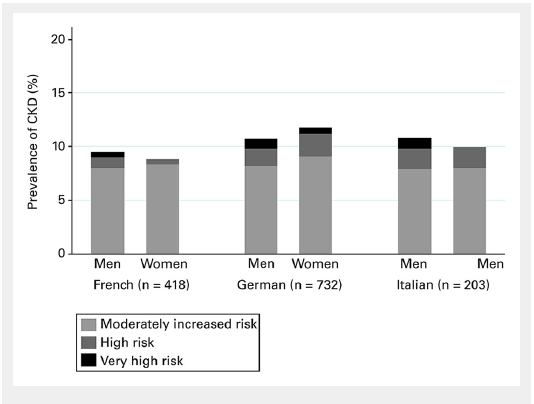
Prevalence of chronic kidney disease (KDIGO 2012), by gender and linguistic region. p-value not significant for difference between genders for each linguistic region (chi squared test); p-value not significant for difference between linguistic regions (chi squared test). KDIGO = Kidney Disease – Improving Global